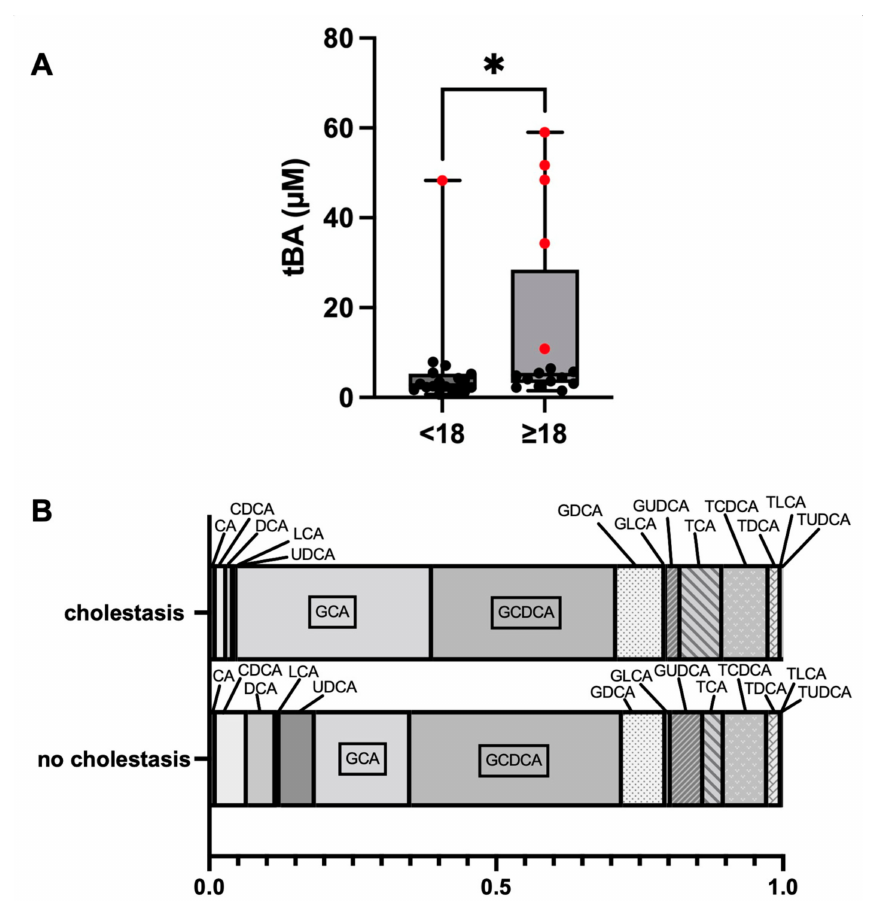
Figure 1. Comparison of the distribution of total bile acid (tBA) concentrations between Fontan patients <18 and ≥ 18 years of age. Cholestatic patients are highlighted by the red dots ( A ). BA profiles of cholestatic and non-cholestatic Fontan patients ( B ). * p ≤ 0.05. Abbreviations: See Supplementary Table